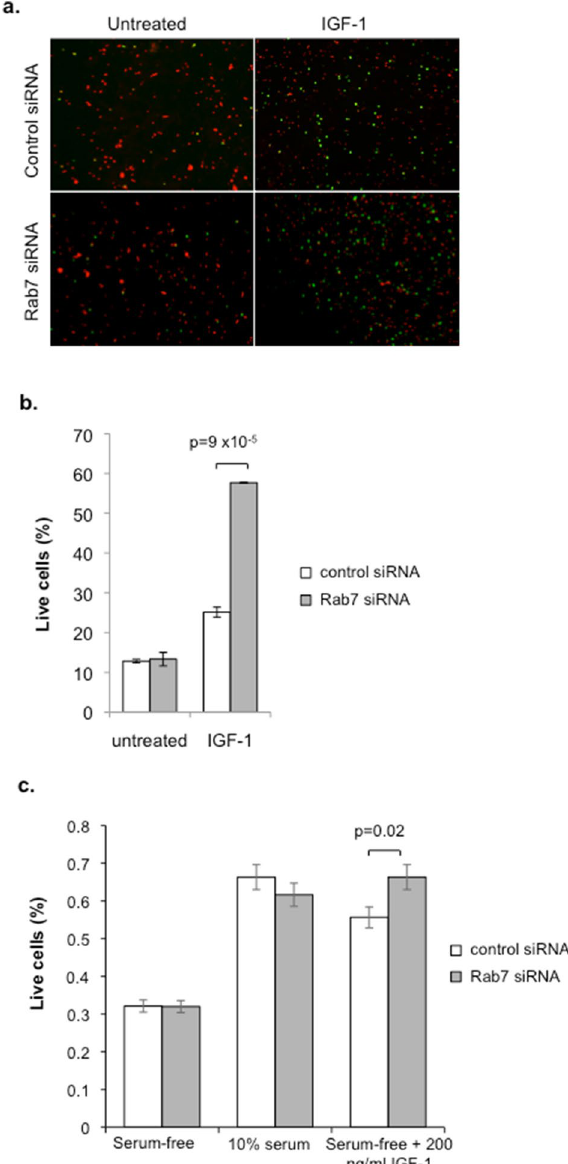
Figure 5. Pancreatic islet survival is enhanced by Rab7a siRNA knockdown. Islets were transfected with Rab7a siRNA or negative control siRNA for 3 days, then dispersed into single cells by Accutase treatment and seeded onto poly-lysine coated coverslips in complete medium. Islet cells were then serum starved (0% FBS) for 12 h, then either treated with or without 200 ng/ml IGF-1. After 2 days, cells were treated with calcein AM (green live stain) and ethidium homodimer-1 (red dead stain) and imaged. Representative images of the overlaid channels are shown ( a ), and ( b ) shows the mean % live cells for n = 3 independent experiments. ( c ) Similar experiments were also performed with intact islets (without Accutase treatment). As an additional control in this experiment, control- and Rab7a-siRNA treated cells did not undergo serum starvation and were instead maintained in 10% FBS. Graph shows mean % live cells (n = 3). Statistical analysis was performed using Students’